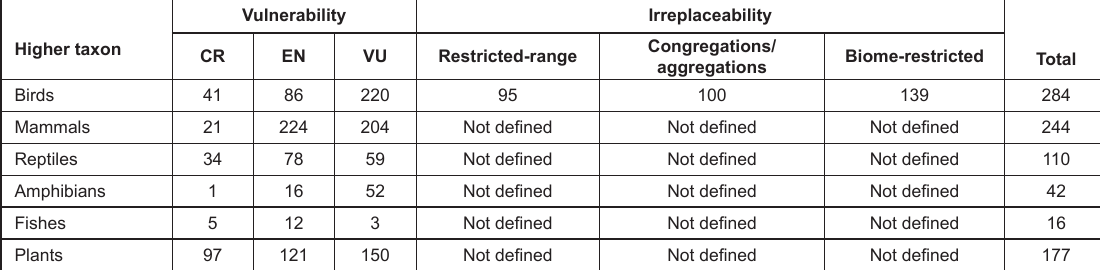
Table 3. Number of KBAs triggered by each of the criteria/subcriteria for each higher taxonomic group